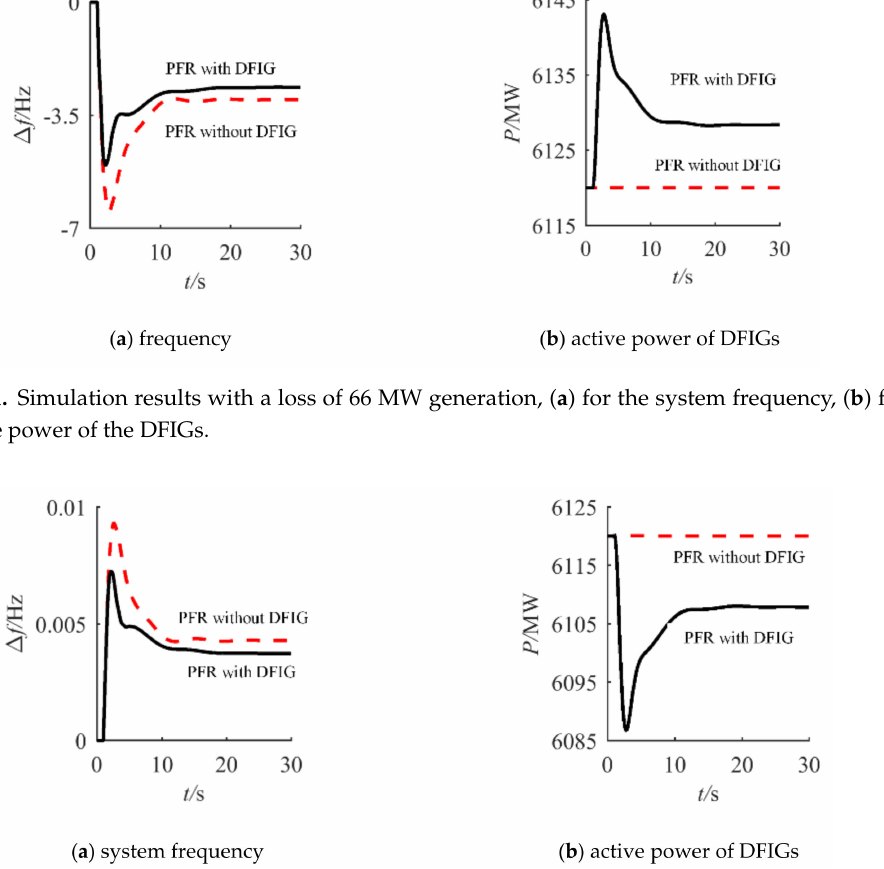
Figure 12. Simulation results with a loss of a 94 MW load, ( a ) for the system frequency, ( b ) for the active power of the DFIGs.